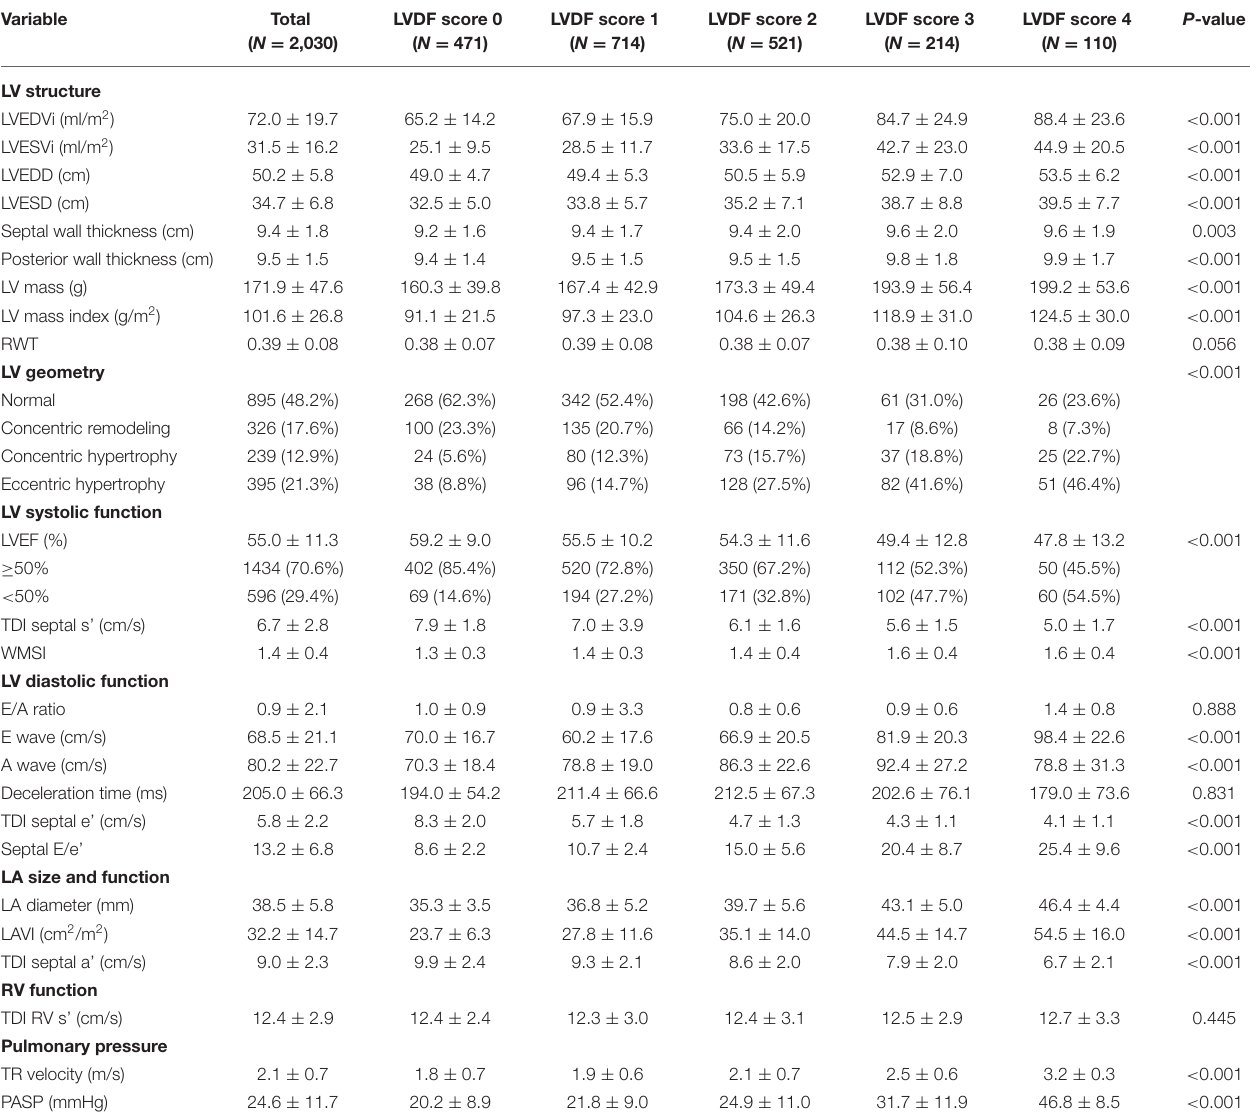
TABLE 2 | Transthoracic Echocardiographic